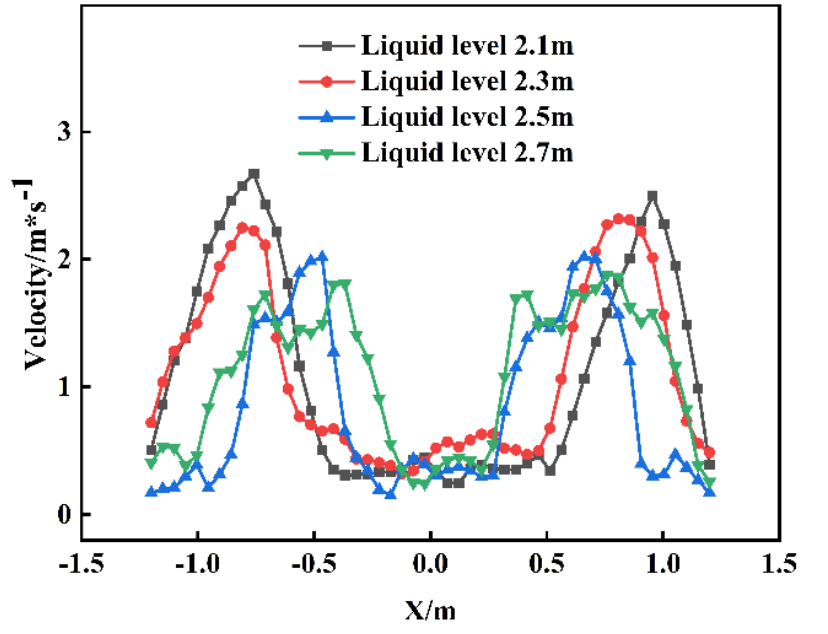
Figure 11. Velocity of bubbles floating to the initial liquid level.